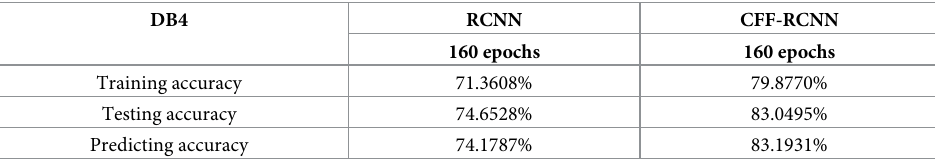
Table 7. Comparison of RCNN and CFF-RCNN on all the subjects in